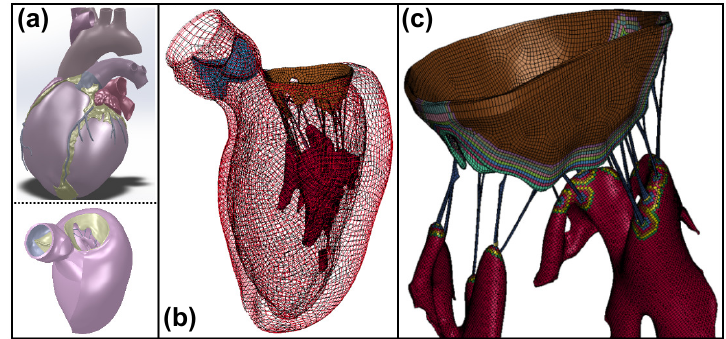
Figure 10. ( a ) Representative image of the whole heart and extracted left ventricle CAD (adopted from the Zygote Media Group, Inc. [58]), ( b ) meshed representation and ( c ) transition regions in the FGM